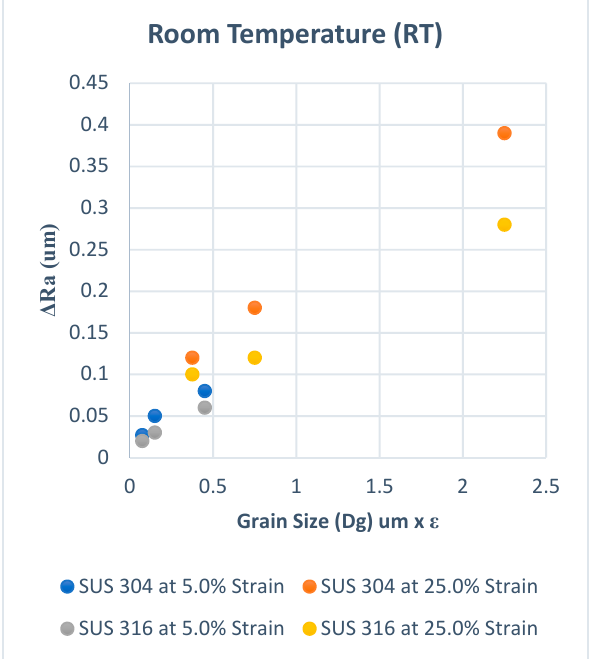
Figure 10. Δ Ra versus Dg × ε at room temperature (RT). Figure 10. ∆ Ra versus Dg × ε at room temperature